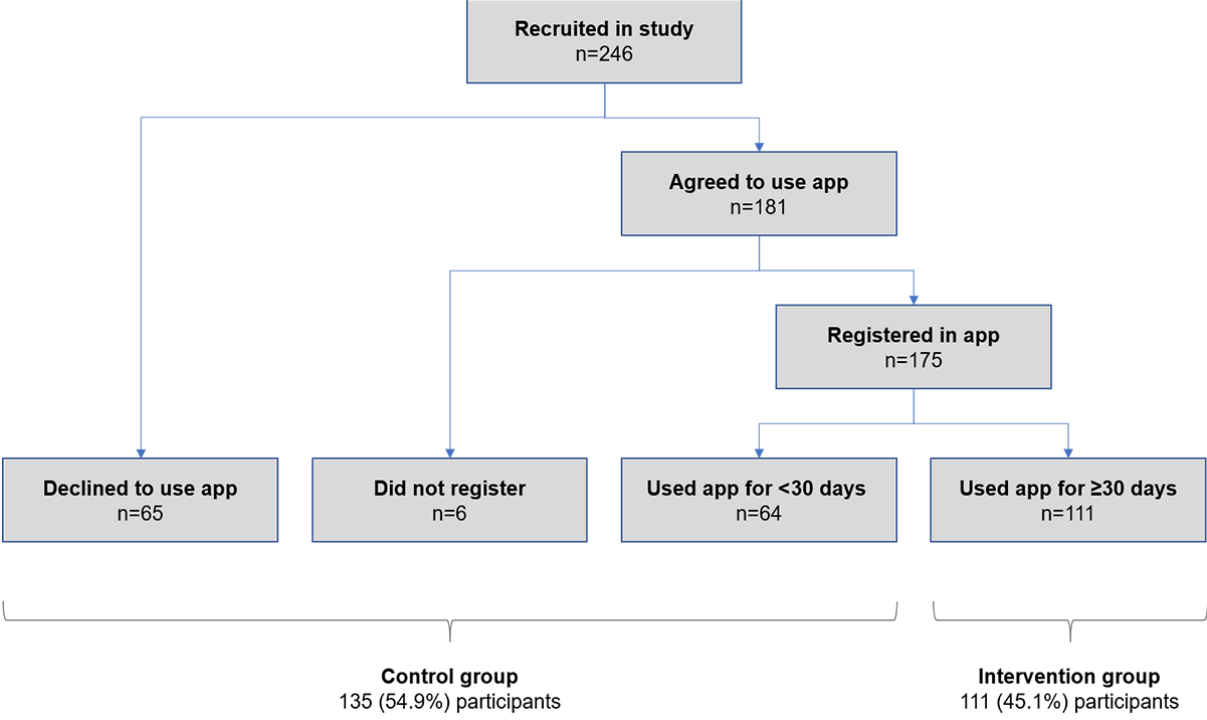
Figure 3. Flow diagram of group allocation based on participants’engagement with the